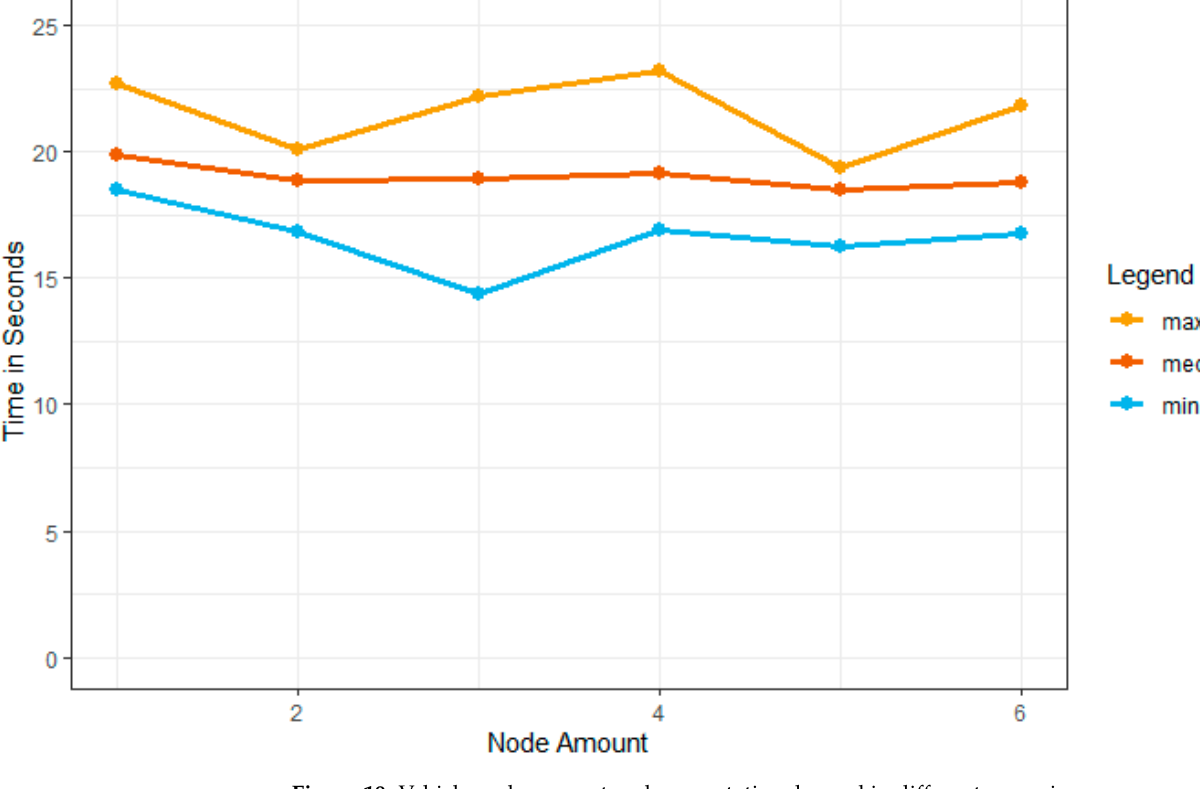
Figure 19. Vehicle node amount and computational speed in different scenarios.